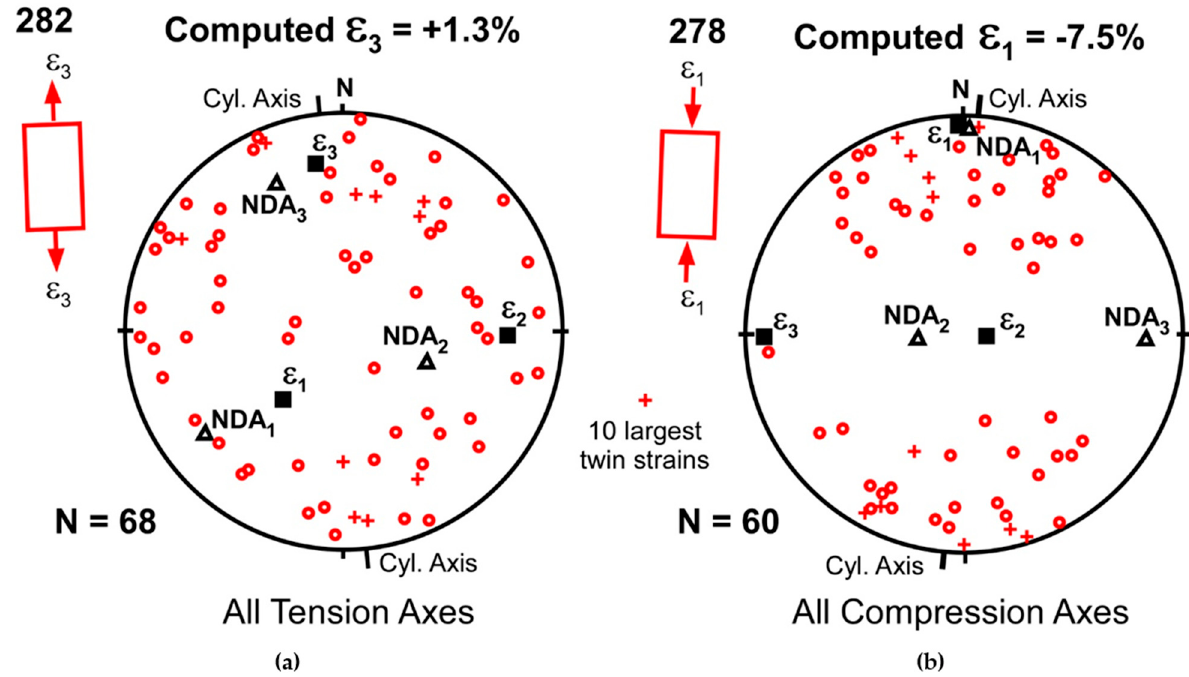
Figure 3. Comparison between sample 282 with zero axial shortening and sample 287 with − 7.5% axial shortening. Turner [1] dynamic analysis axes (circles and + signs), along with calculated principal axes for the Spang [12] numerical dynamic analysis (NDA) and the Groshong strain gauge technique ( ε ); all data modified from [10]. Lower-hemisphere equal-area projections in the thin-section coordinate system. The orientation of the cylinder axis relative to the thin section coordinate system is shown schematically by rectangles. The long axis of the sample cylinders (short lines labeled Cyl. Axis) are not quite parallel to the long axis of the thin section: ( a ) sample 282; ( b ) sample 278.